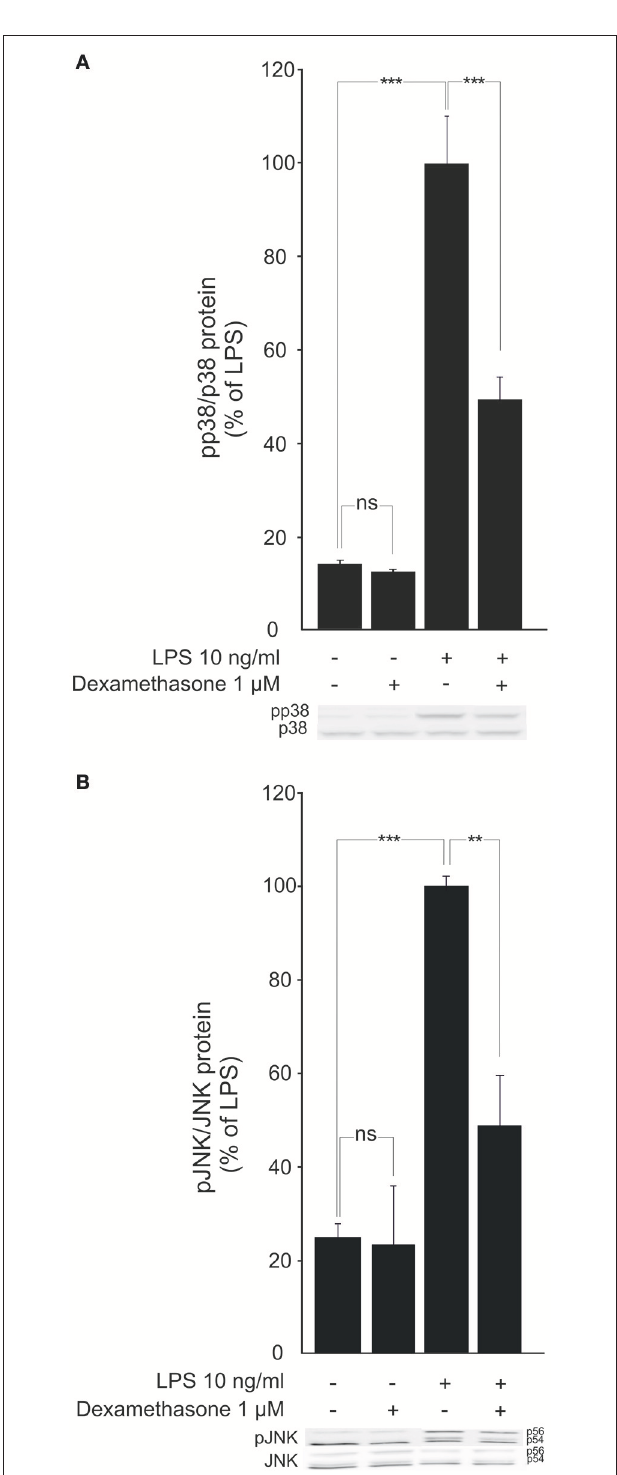
FIGURE 4 | Dexamethasone inhibits the phosphorylation of MAP kinases p38 and JNK in activated J774 macrophages. (A) Effect of dexamethasone on p38 phosphorylation. J774 macrophages were preincubated with dexamethasone for 1 h and stimulated with LPS for 30 min. p38 and phosphorylated p38 (pp38) protein levels were measured by Western blot analysis and the levels of